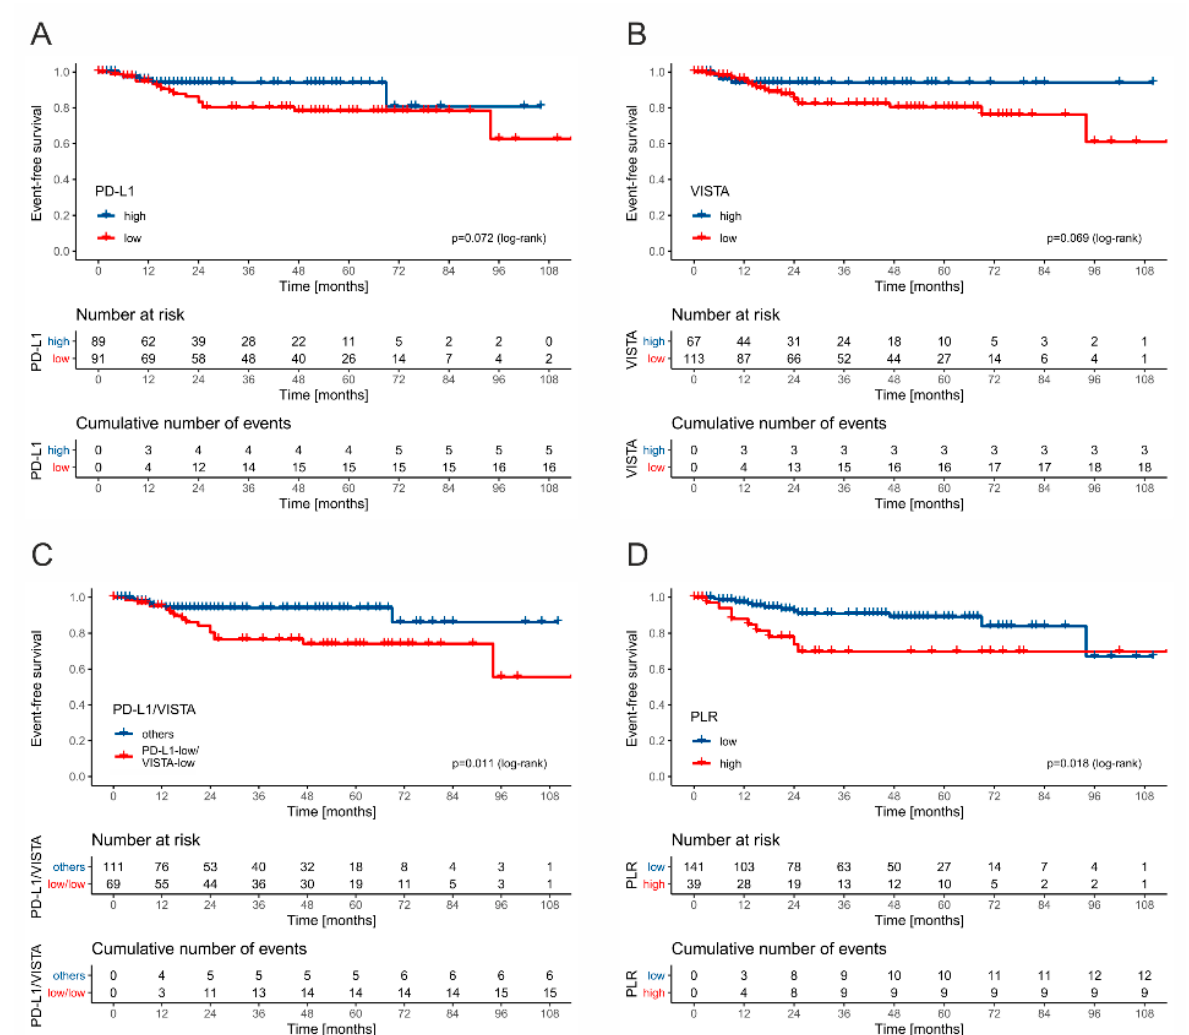
Figure 6. The Kaplan–Meier curves for event-free survival stratified by PD-L1 ( A ), VISTA ( B ), combined PD-L1 and VISTA ( C ), and PLR ( D ).